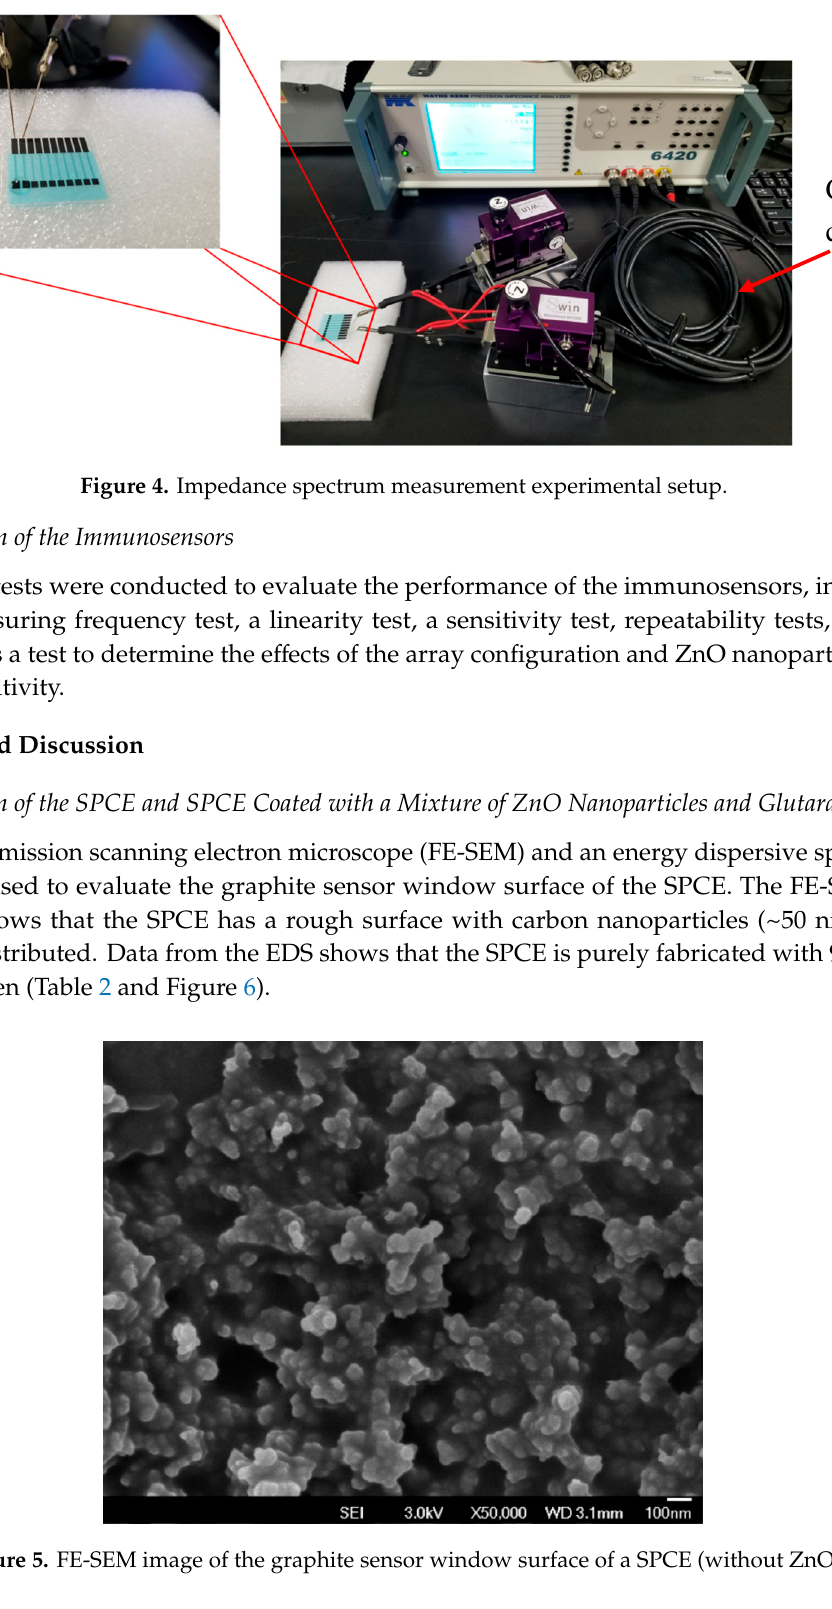
Figure 6. EDS of the graphite sensor window surface for the SPCE. Table 2. EDS showing the composition of the graphite sensor window for the SPCE. Element